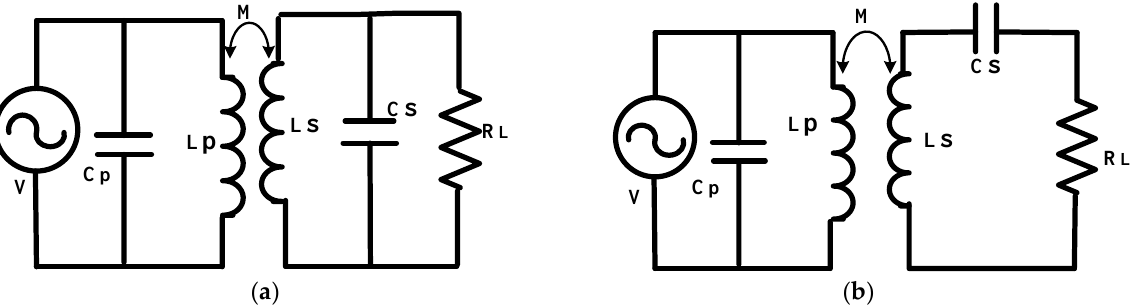
Figure 4. Equivalent circuit of Parallel compensation ( a ) Parallel–Parallel topology ( b ) Parallel–Series topology.